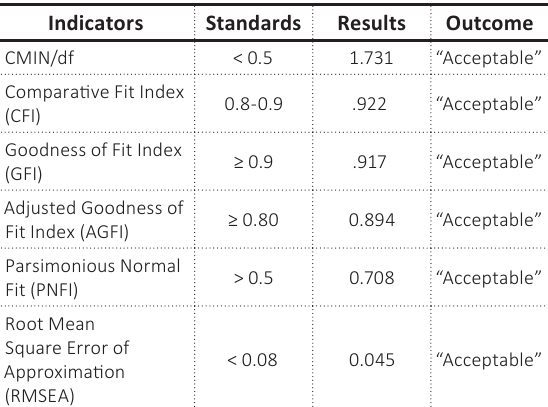
Table 5. CFA results